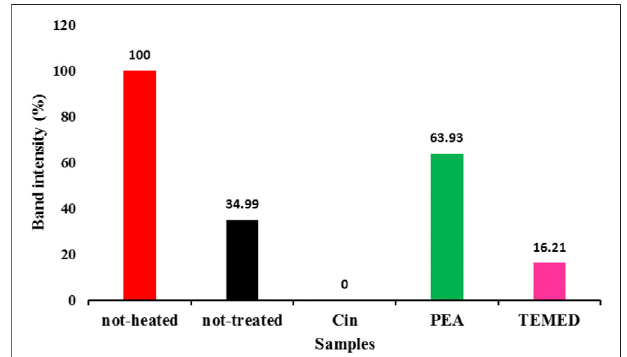
FIGURE 6 | Quantitative measurement of the monomeric form of tau proteinbandbyImageJsoftware. Thequanti fi cationofthemonomericformof tau protein band is related to the SDS-PAGE samples described in Figure 5 .